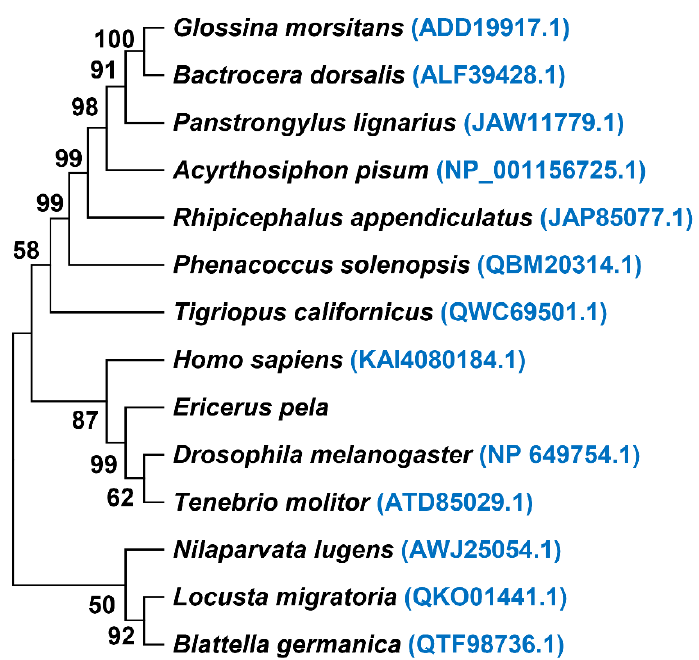
Figure 6. Phylogenetic tree of elongation of very-long-chain fatty acid protein (ELOVL) in 14 species. The phylogenetic tree was constructed using the neighbor-joining method with 1000 bootstrap replicates. Each species was followed by its GenBank accession number.